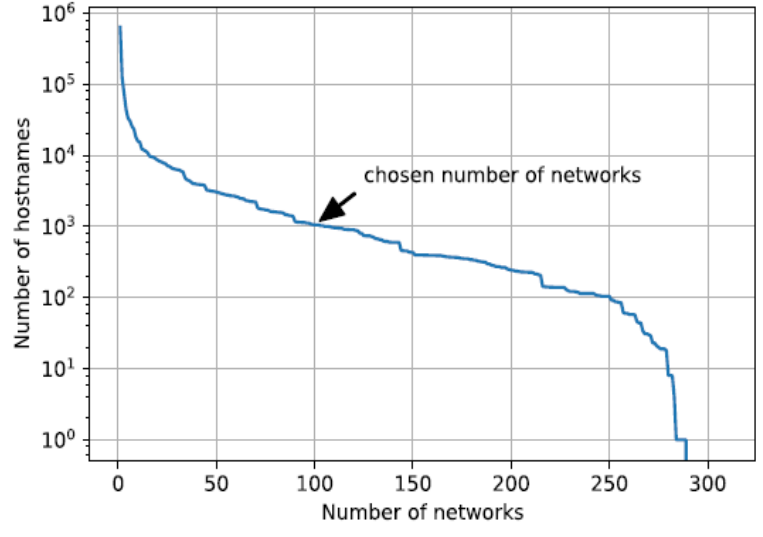
Figure 6. Network intersection sizes.